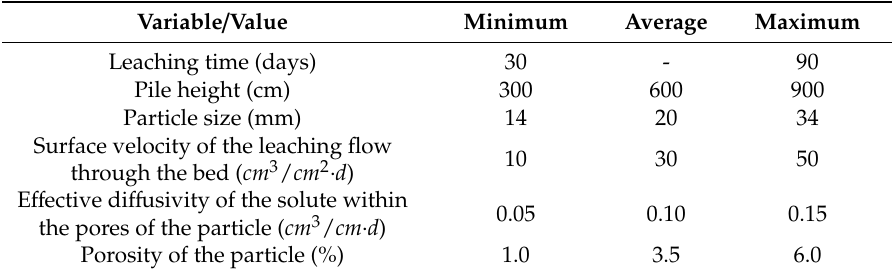
Table 1. Summary of minimum, average and maximum values of the operational